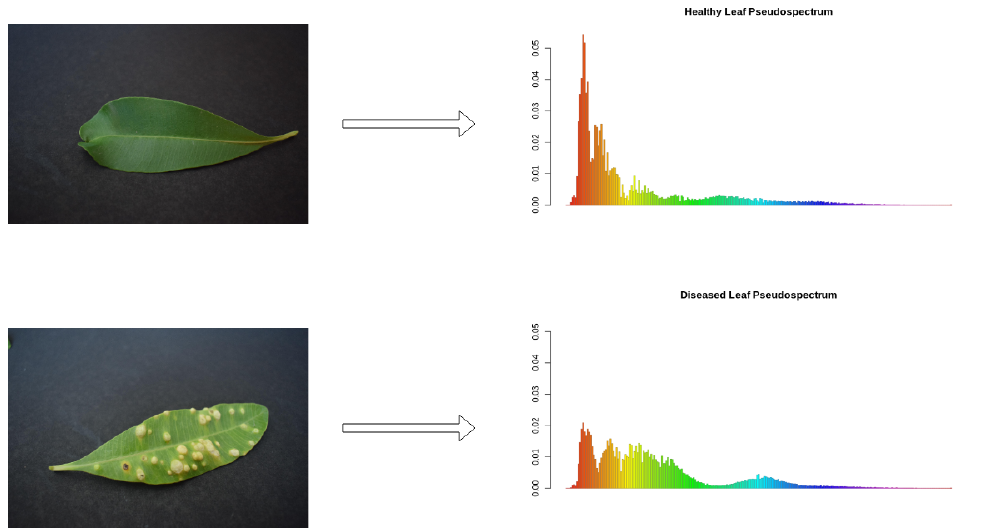
Figure 9. Pseudospectrum extraction